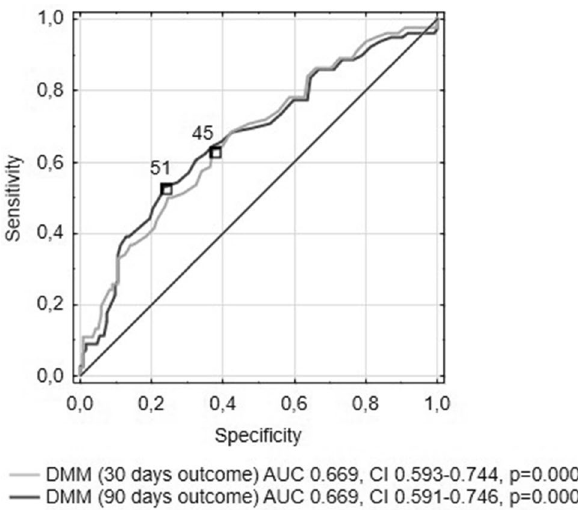
Figure 2. ROC analysis of PP DMM and 30- and 90-days unfavorable outcome. AUC area under the curve, CI confidence interval, DMM difference maximum-minimum, PP pulse pressure, ROC receiver operating